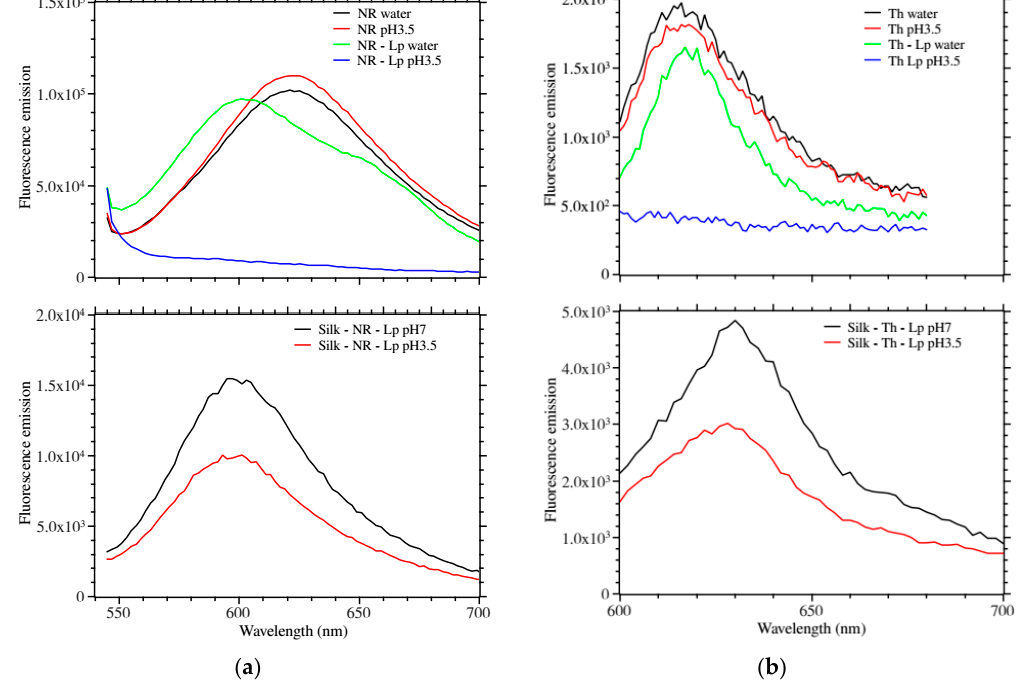
Figure 3. Fluorescence emission profiles. ( a ) Top , comparison of free neutral red in water, at pH 3.5; and neutral red bound to Laponite ® in water and at pH 3.5 (excitation at 540 nm). With acidification, the Laponite ® modified neutral red displayed a strong quenching as compared to the free dye; Bottom , comparison of silk patches containing neutral red and Laponite ® at pH 7 and pH 3.5. The fluorescence emission was quenched at low pH for both dyes; ( b ) Top , comparison of free thionine in water and at pH 3.5; and thionine bound to Laponite ® in water and at pH 3.5 (excitation at 595 nm). With acidification, the Laponite ® modified thionine displayed strong quenching as compared to the free dye; Bottom , comparison of silk patches containing thionine and Laponite ® at pH 7 and pH 3.5. The fluorescence emission was quenched at low pH for both dyes.